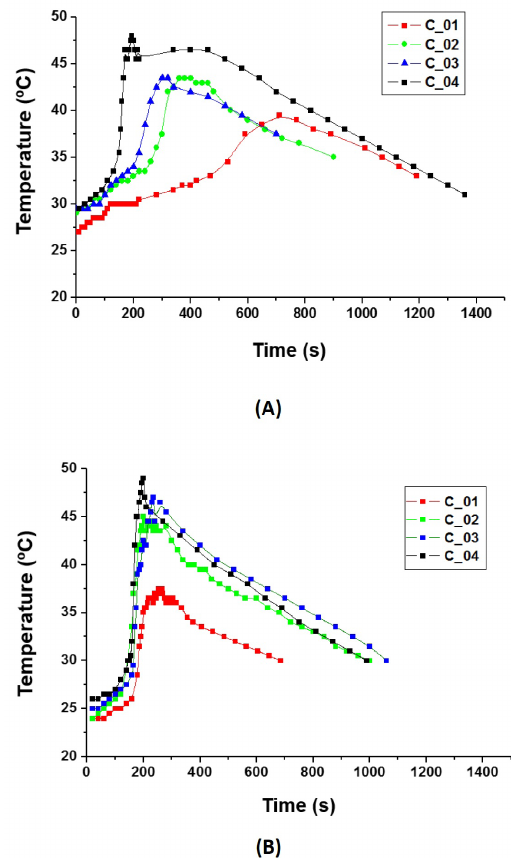
Figure 12. Temperature measured by pyrometry as a function of the time after mixing, of the magnesium phosphate cements prepared from MgO powders calcined at (A) 900 °C / 2 h and (B) 1100 °C / 2 h, with different MgO/NH